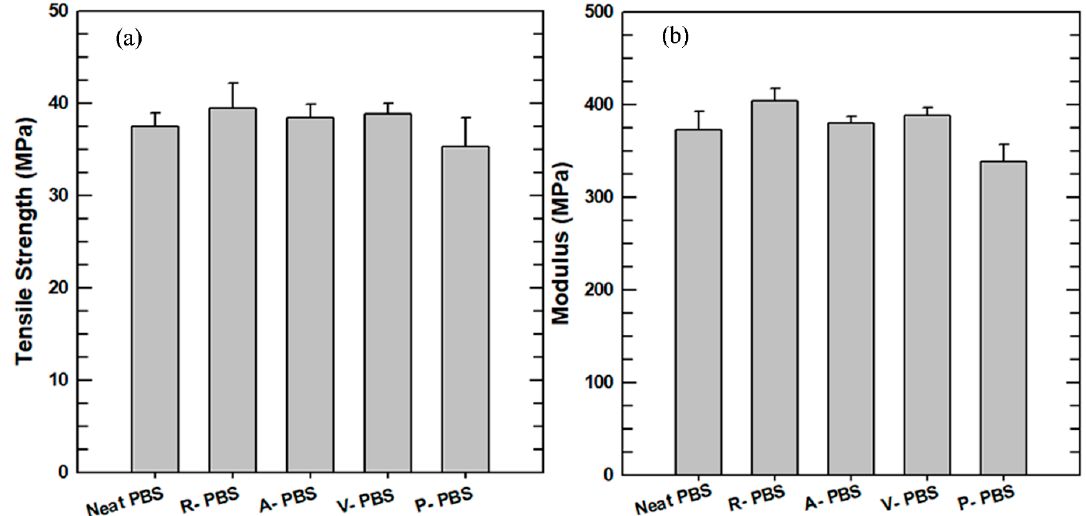
Figure 8. Tensile properties ( a ) tensile strength, and ( b ) Young’s modulus.